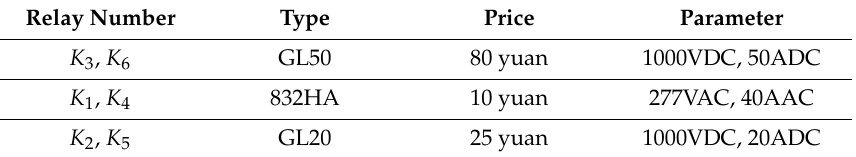
Table 1. Type, price, and parameters of relays used in the experiment